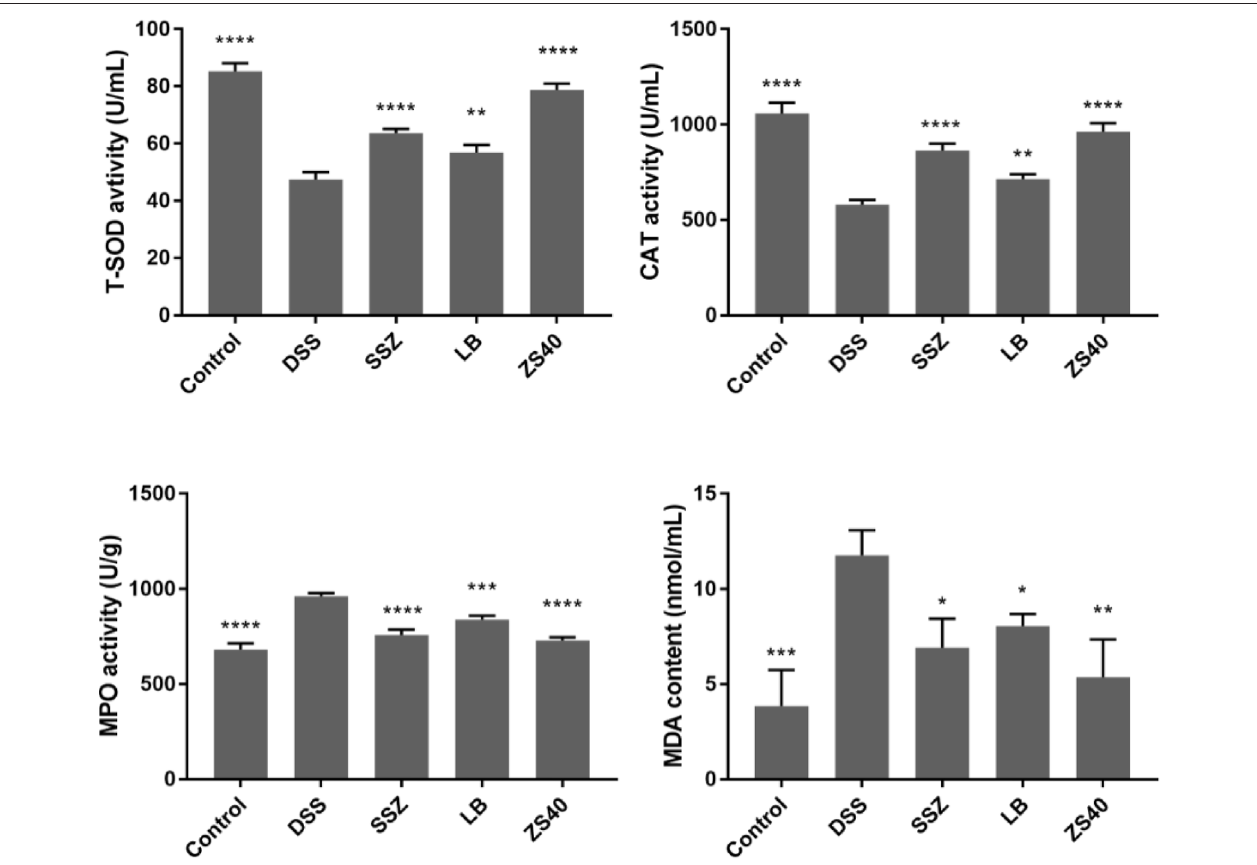
FIGURE 4 | The levels of superoxide dismutase (T-SOD), myeloperoxidase (MPO), catalase (CAT) and malondialdehyde (MDA) in serum of mice. Control group (cid:2) gavage with saline, DSS group (cid:2) 3% dextran sulfate sodium, SSZ group (cid:2) 500 mg/kg body weight (b.w.) salicylazosulfapyridine treatment dose, LB group (cid:2) 1.0 × 10 9 CFU/kg body weight (b.w.) L. bulgaricus treatment dose, ZS40 group (cid:2) 1.0 × 10 9 CFU/kg body weight (b.w.) L. fermentum ZS40 treatment dose. Data are expressed as mean ± SD; * p < 0.05, ** p < 0.01, *** p < 0.001, **** p < 0.0001 compared with the DSS